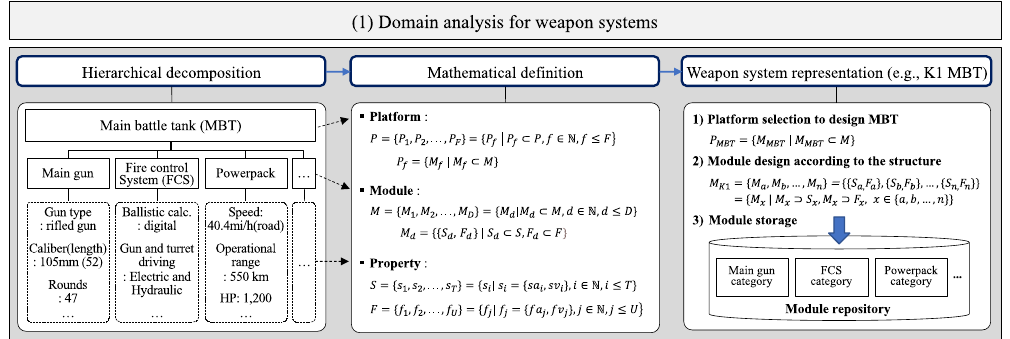
Figure 6. Flow of actions for the domain analysis.